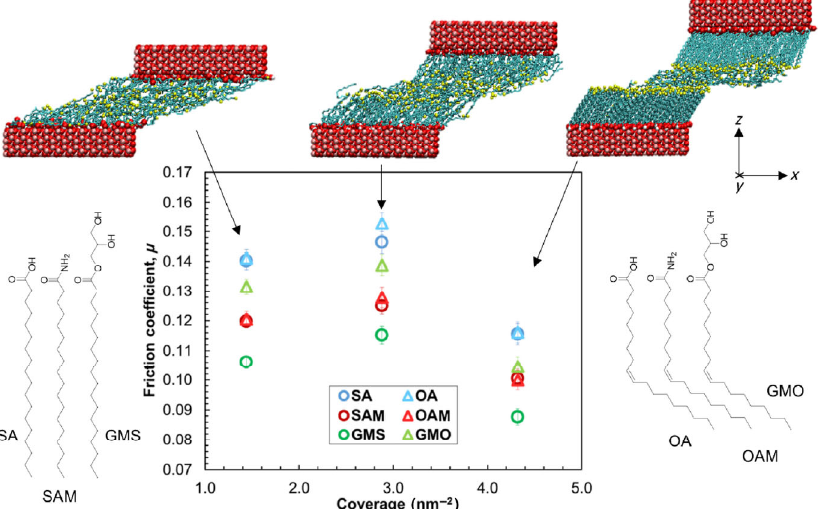
Fig. 5 Effect of OFM surface coverage on the friction coefficient from NEMD simulations (298 K, 0.5 GPa, 10 m·s − 1 ). Adapted from Ref.